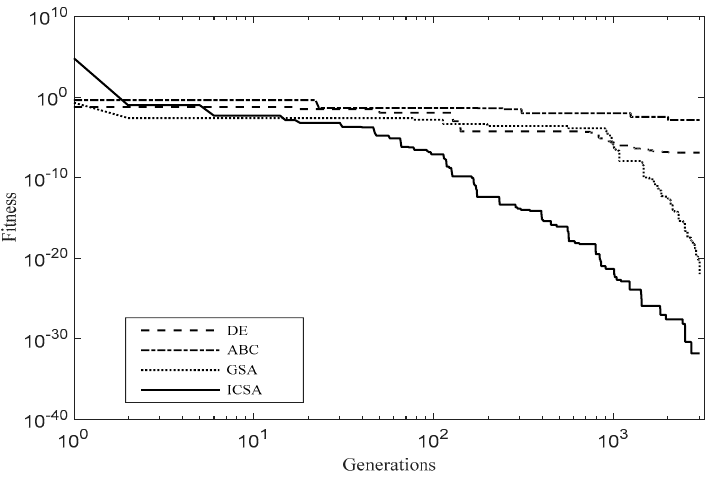
t ( ) for motor 1. AM